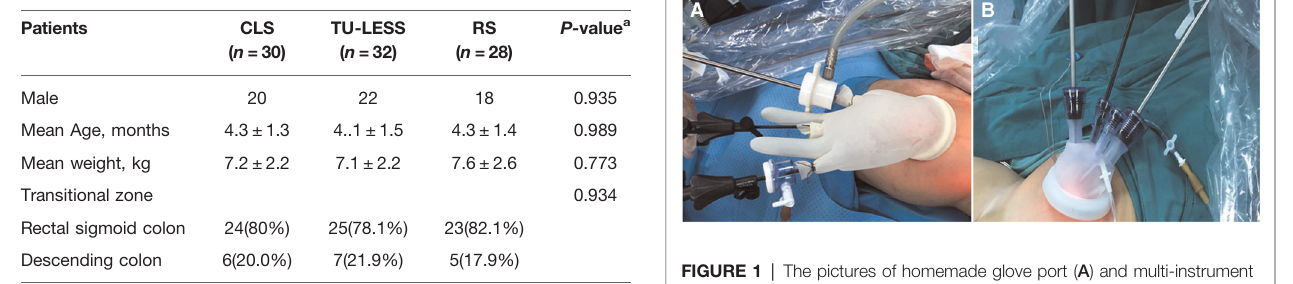
TABLE 1 | Patients ’ demographics.